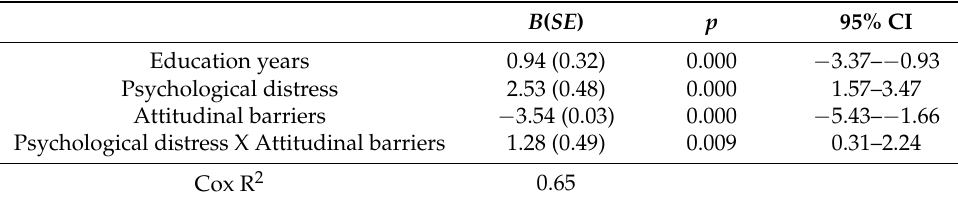
Table 3. Moderation Effect of Psychological Distress in the Relationship between Barriers to Mental Health Services and Service